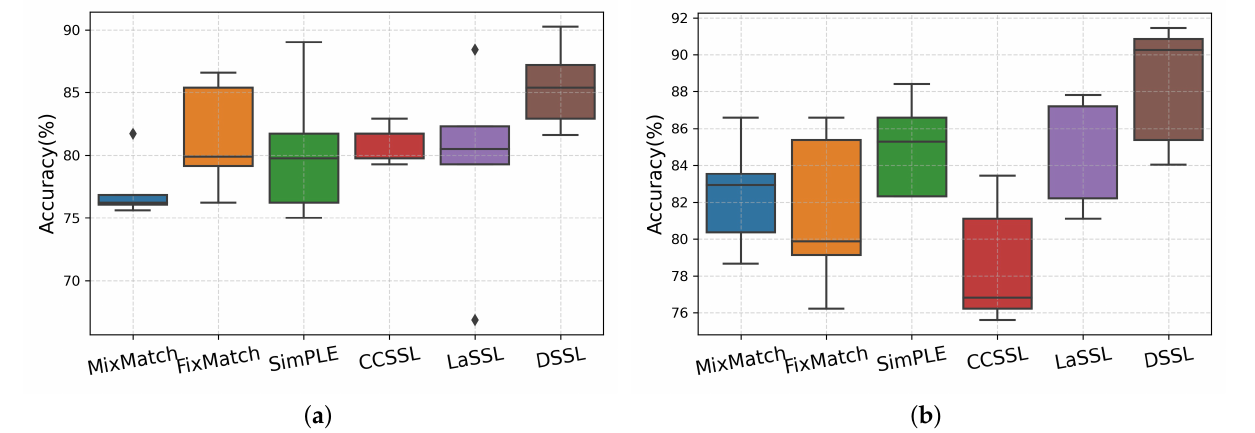
Figure 5. Illustrating ( a ) each model’s accuracy in a 5-fold cross-validation experiment in the 60-label case and ( b ) each model’s accuracy in a 5-fold cross-validation experiment in the 120-label case. Although we achieve the best classification results in the 5-fold cross-validation ex- periments, the selection of different labeled data can seriously affect the classification performance for the SSL algorithm. We randomly select labeled samples from the train- ing set and repeat this process 100 times to obtain 100 division results. We train these 100 divisions sequentially to observe the stability of the algorithm. The variance of the 100 times predictions for the DSSL and each baseline are shown in Table 6. For visualization purposes, we select the three models with the slightest variance in each of the two cases and plot their 100 times results as line graphs, as shown in Figure 6. It can be seen that the variance of DSSL is the lowest in both the 60-label and 120-label cases, which indicates that DSSL is more stable than the other baseline methods. In addition, the variance of the model with 120 labels is generally smaller than that of the case with 60 labels, suggesting that the increase in the number of labeled samples improves the stability of the SSL